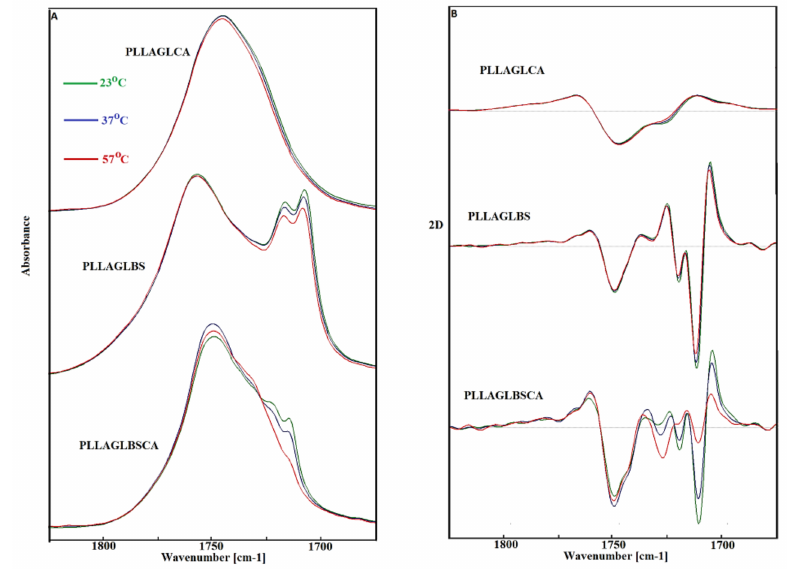
Figure 9. FTIR spectra of PLLAGLBS, PLLAGLCA, and PLLAGLBSCA blends ( A ) and their second derivative spectra ( B ) recorded at 23, 37, and 57 ◦